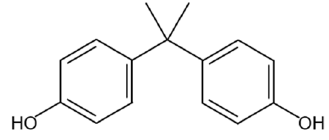
Figure 1. The chemical structure of BPA. Table 1. Properties of four MFMs.